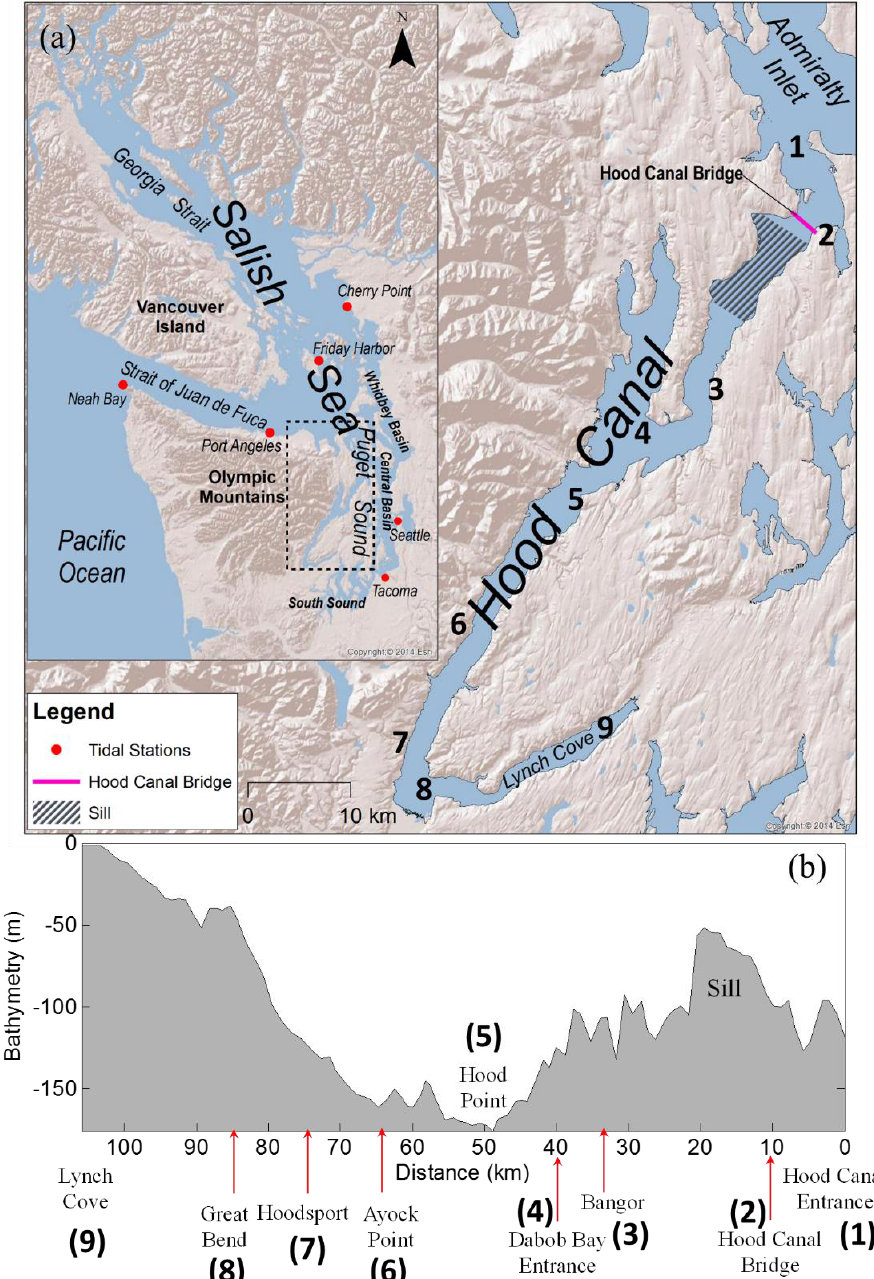
Figure 1. ( a ) Oceanographic regions of Salish Sea including Northwest Straits, Puget Sound, and the inner sub-basins—Hood Canal, Whidbey Basin, Central Basin, and South Sound; ( b ) bathymetric profile of Hood Canal study area.